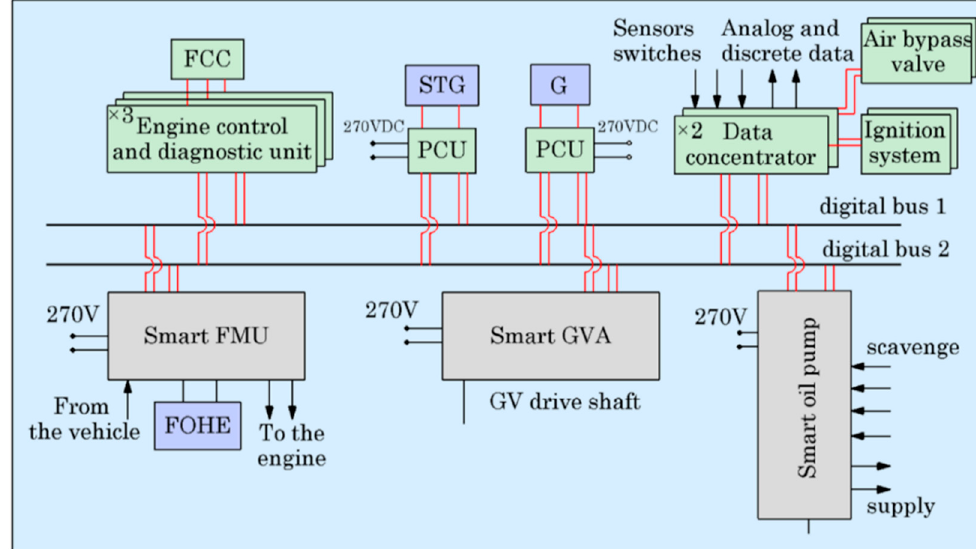
Figure 18. Proposed distributed architecture scheme of a more electric engine for middle-sized UAV (for small-sized UAV the scheme is equal except one digital bus). FOHE—fuel oil heat exchanger; FMU—fuel metering unit; GVA—guide vanes actuator; FCC—flight control controller; SG—starter-generator; G—generator; PCU—power control unit.